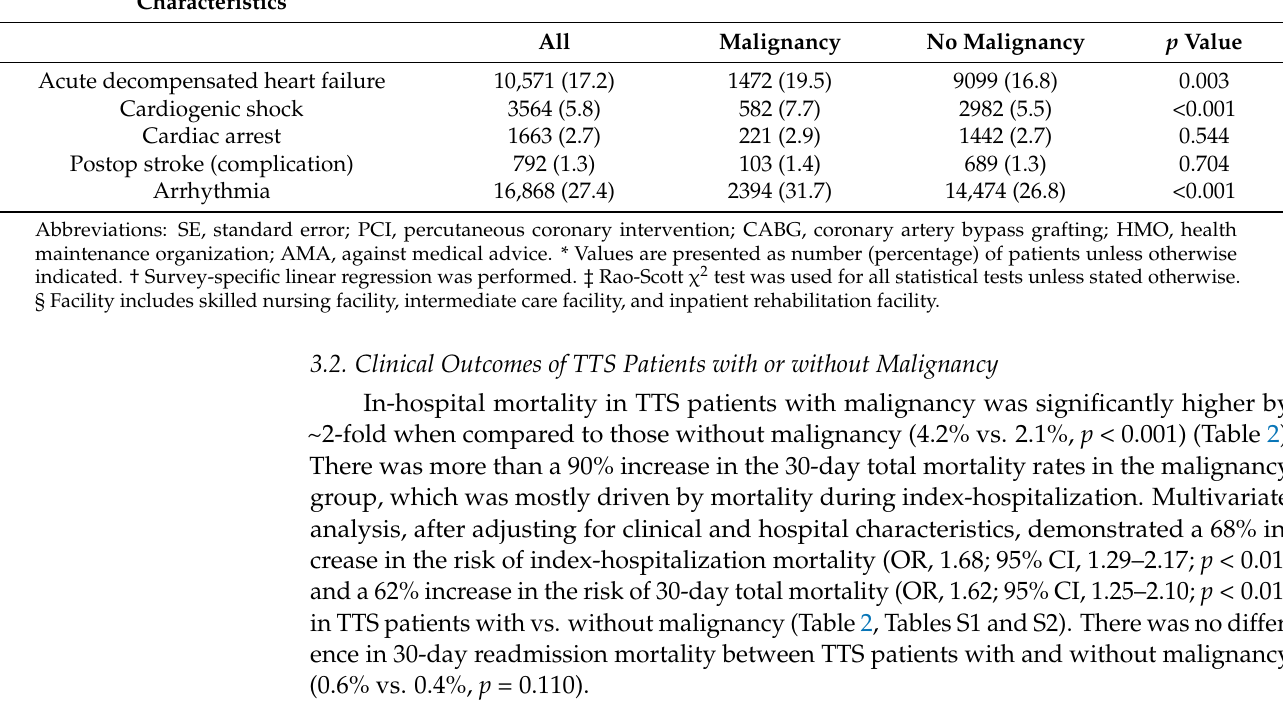
Table 2. In-hospital and 30-day Outcomes of Takotsubo Syndrome.